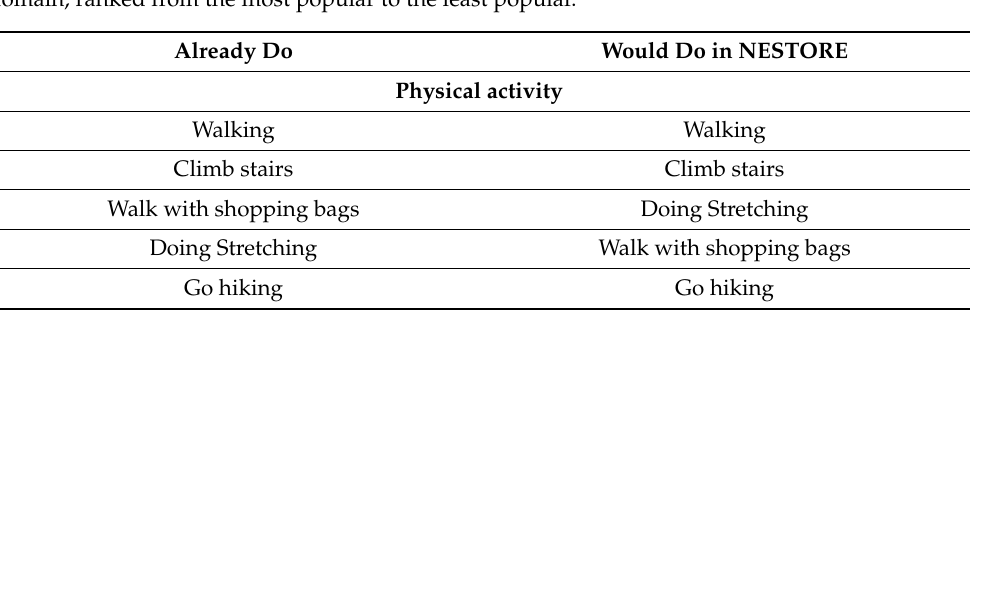
Table 1. List of 5 most popular activities that participants already do and would do in NESTORE domain, ranked from the most popular to the least